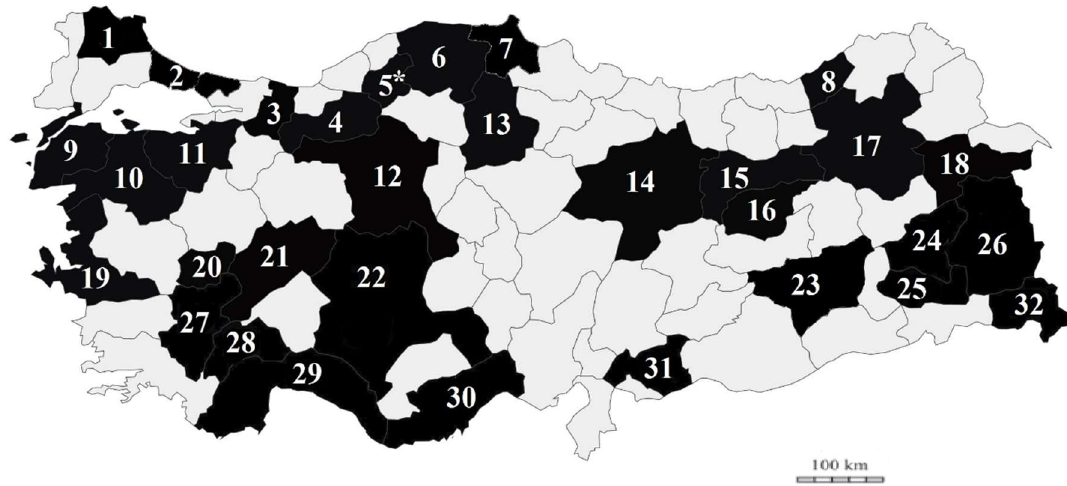
Figure3. The mapof Turkey includingall tardigrade species were reported from32 provinces (marked in dark) From left to right: 1—Kırklareli, 2—˙Istanbul, 3—Sakarya, 4—Bolu, 5—Karabük *, 6—Kastamonu,